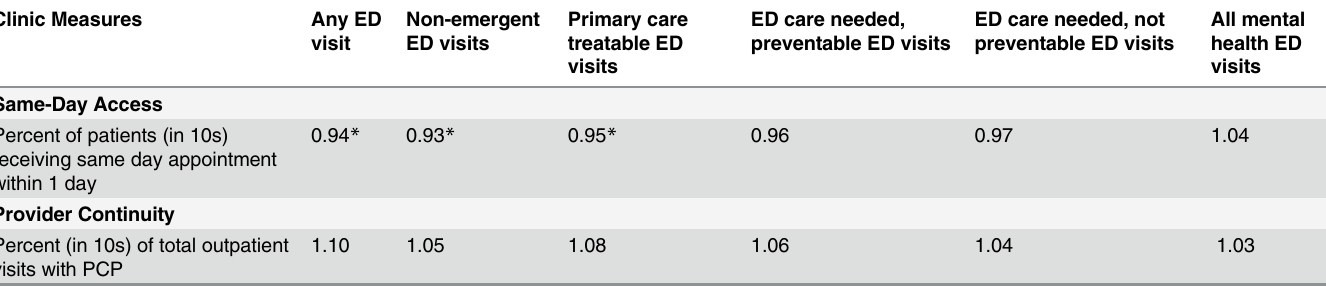
point higher percent of patients getting timely access was estimated to reduce non-emergent visits by 7% (IRR = 0.93; P < 0.001). For ED visits that were emergent but considered primary care treatable, higher access was also associated with a lower ED visit incidence rate (IRR = 0.95; P < 0.001). There were no significant associations between continuity and these types of ED visits. There were smaller and non-significant associations with both higher access and continuity for ED visits where ED care was needed and care was preventable (P = 0.016 and P = 0.229, respectively), ED visits where ED care was needed and care was not preventable (P = 0.014 and P = 0.257, respectively), and ED visits for mental health conditions including psychiatric, alco- hol, and drug use disorders (P = 0.025 and P = 0.335, respectively). Table 4. Incidence Rate Ratios of ED Visits by Type from Adjusted Models FY2010-2012, N = 71,296 Clinic Measures Any ED Primary care ED care needed, ED care needed, not All mental visit treatable ED preventable ED visits preventable ED visits health ED visits